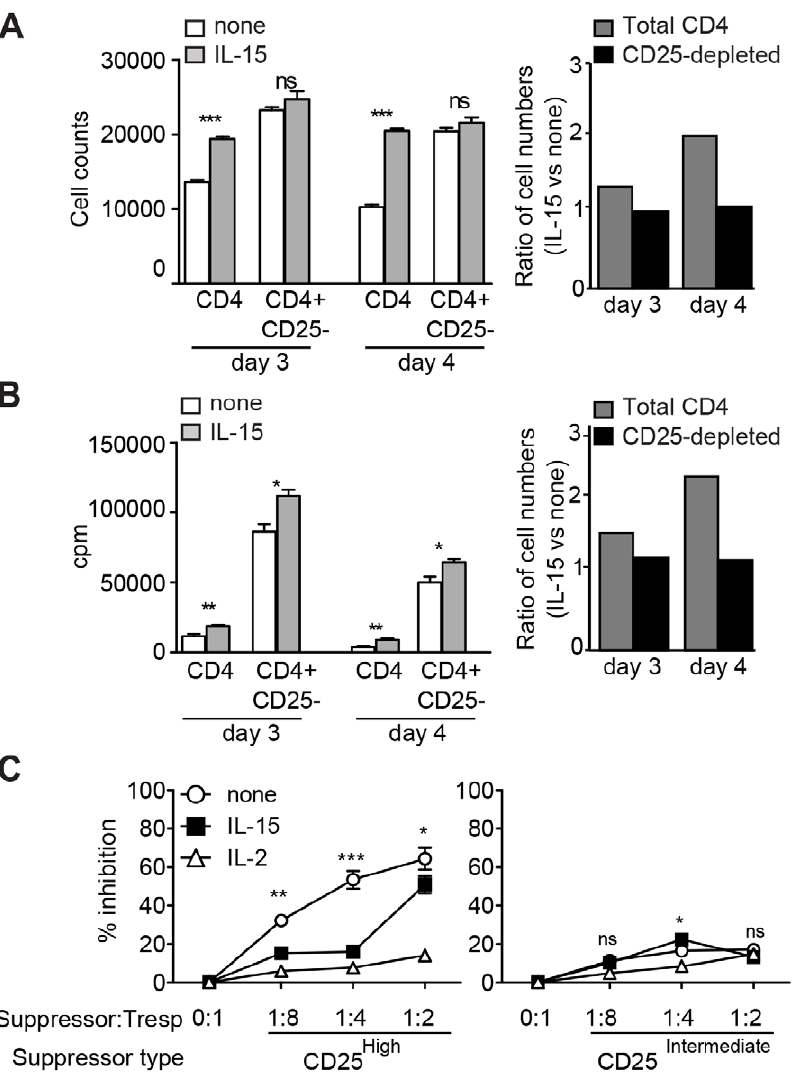
Figure 6. IL-15 blocks suppression by CD25 High CD4 + T cells. (A) CD4 + T cell numbers and (B) proliferation of total CD4 + T cells (white bars) or CD25-depleted CD4 + T cells (grey bars) stimulated with anti-CD3 mAb, irradiated TdACs and supplemented or not with IL-15. Data are expressed as absolute values (left panels) or fold increase of IL-15-supplemented versus non-supplemented cultures (right panels; 1 reflects no effect of IL-15 addition). Bar graphs represent the mean 6 SEM. Statistical significance was calculated by student t-test, ns: not significant, * P , 0.05, ** P , 0.01, *** P , 0.001. (C) CD25 2 CD4 + responder T cells (Tresp) were co-cultured with CD25 High (left) or CD25 Int (right) CD4 + T cells, FACS-purified from activated CD4 + T cell cultures as described in Materials and Methods, as putative suppressors at indicated ratios, prior to stimulation with 0.1 m g/ml anti-CD3, irradiated TdACs, and indicated cytokines for 3 days. Proliferation was measured via 3 H-thymidine incorporation and the percent suppression was calculated as follows: % suppression=100 6 (cpm Responder – cpm Coculture )/cpm Responder . Statistical significance between IL-15-supplemented and non- supplemented cultures was calculated using two-way ANOVA with Bonferroni posttest: ns: not significant, * P , 0.05, ** P , 0.01, *** P , 0.001 (statistical analysis versus IL-2-supplemented cultures not shown). All experiments were performed at least 3 times with similar